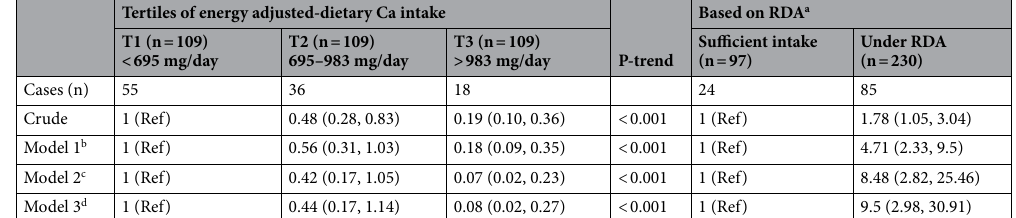
Table 3. Multivariable- adjusted odds ratio and 95% confidence intervals for ulcerative colitis (UC) across tertiles of energy adjusted-dietary Ca intake. All values are odds ratios and 95% confidence intervals. a RDA: Recommended Dietary Allowances for dietary Ca intake (Man: ≥ 1000 mg; Women: 19–50 years: ≥ 1000 mg; ≥ 51 years: ≥ 1200 mg). b Model 1: Adjusted for age, sex, and energy intake. c Model 2: Additionally adjusted for marital status, education, family size, smoking, hypertension, diabetes, physical activity and house ownership. d Model 3: Further adjusted for body mass index